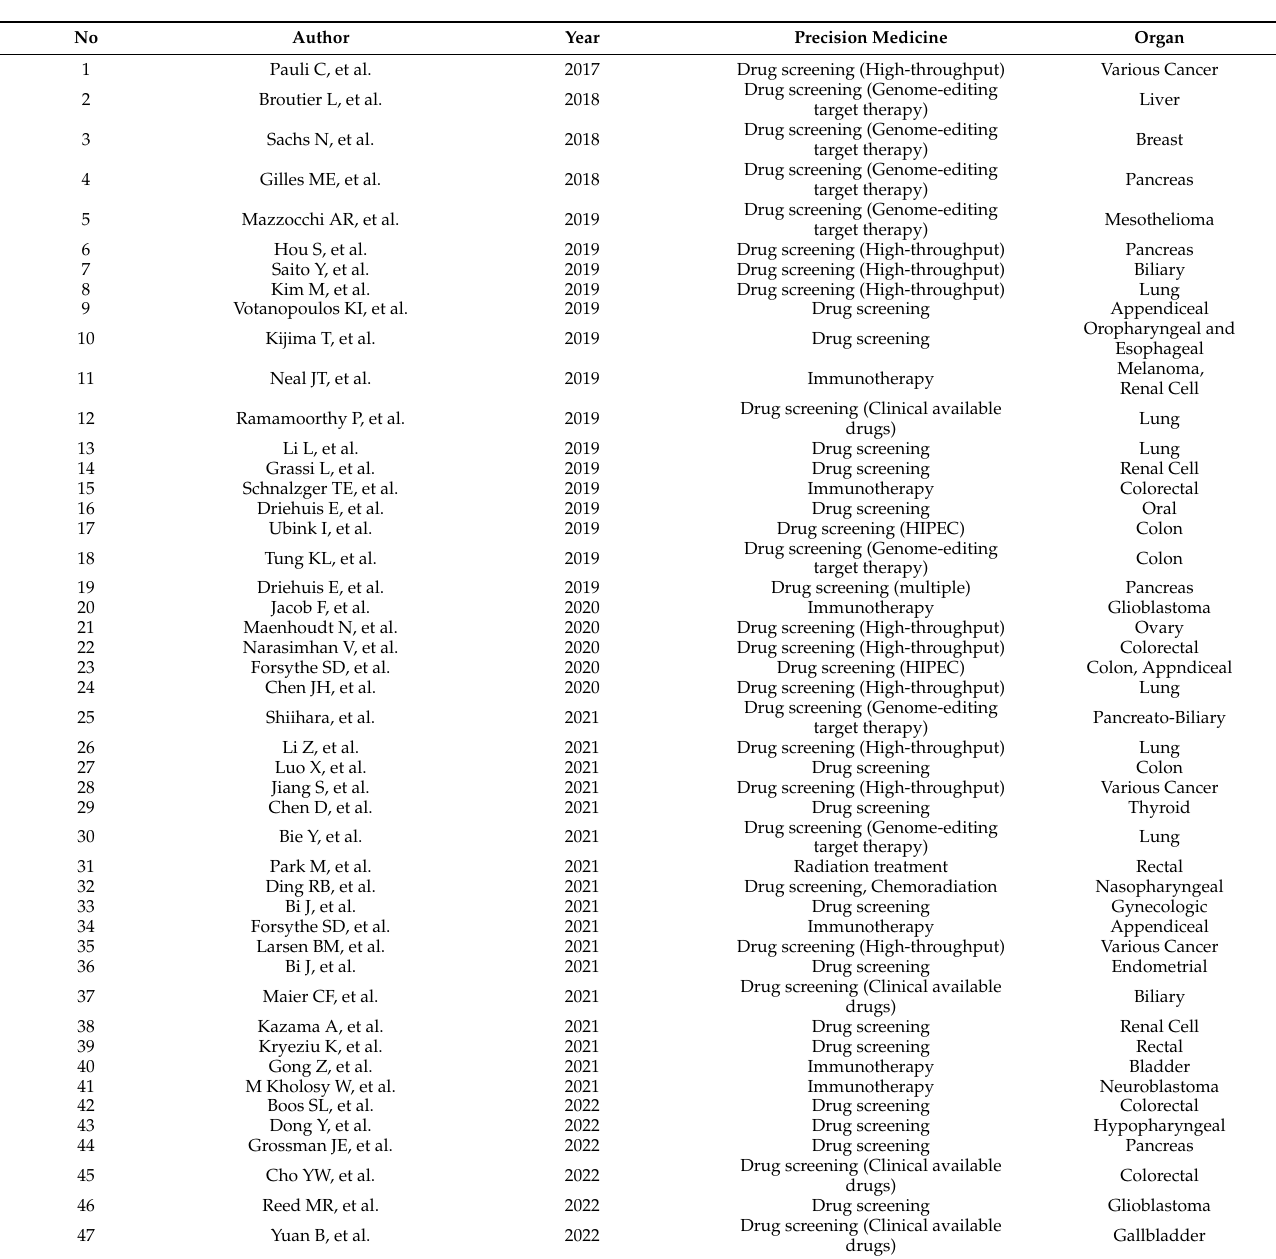
Table 1. Previous reports of personalized medicine model combined patients-derived can- cer